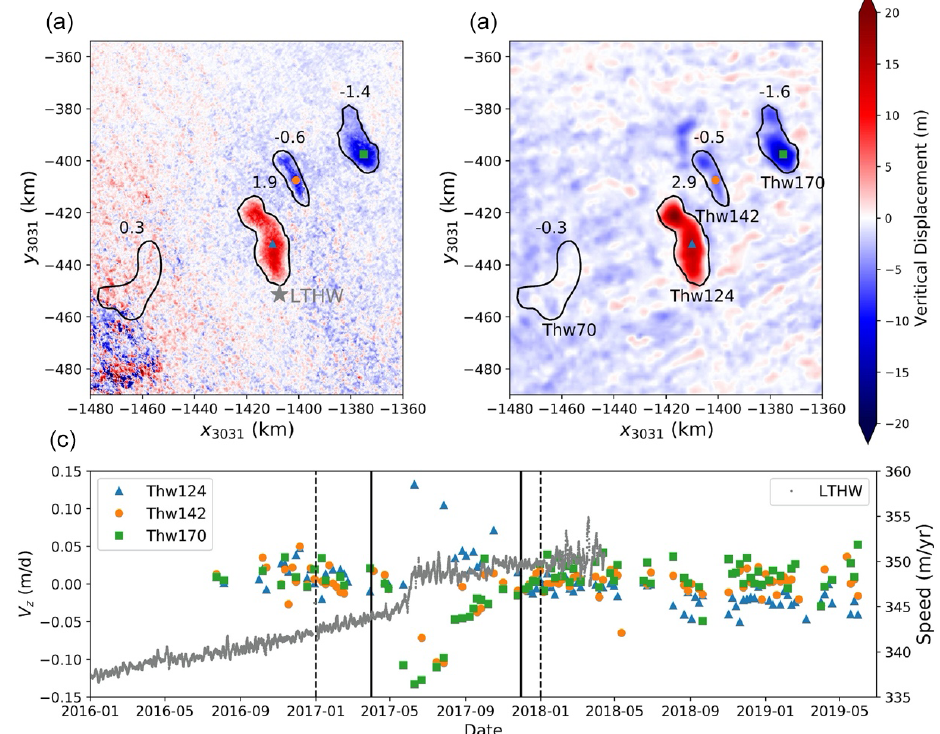
Figure 2. Surface elevation-change time series over the Thwaites Glacier lakes showing the 2017 drainage cascade from (a) vertical dis- placement computed from integrated vertical displacement rates ( V z ) from Sentinel-1 SAR data and (b) swath-processed radar altimetry in a polar stereographic projection (EPSG:3031). Water volume (km 3 ) associated with observed vertical displacement is labeled for each lake. (c) Time series of uplift rates ( V z ) from SAR LOS results (colored dots, left abscissa); locations marked in (a) and (b) and horizontal speed from GNSS observations (right abscissa). Solid lines represent period over which SAR vertical displacements ( V z ) were integrated to produce the vertical displacements shown in (a) . Dotted lines represent the quarters of gridded CryoSat-2 data differenced to create (b)